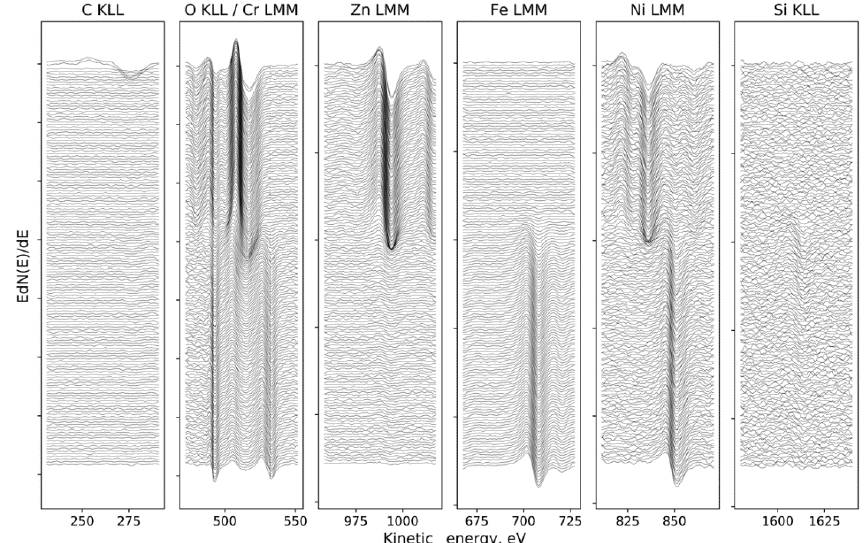
Figure 1. Sandblasted 1500_300: the evolution of the spectral lines for the major element, registered between ion etching cycles, ordered from surface (top) to the substrate (bottom).